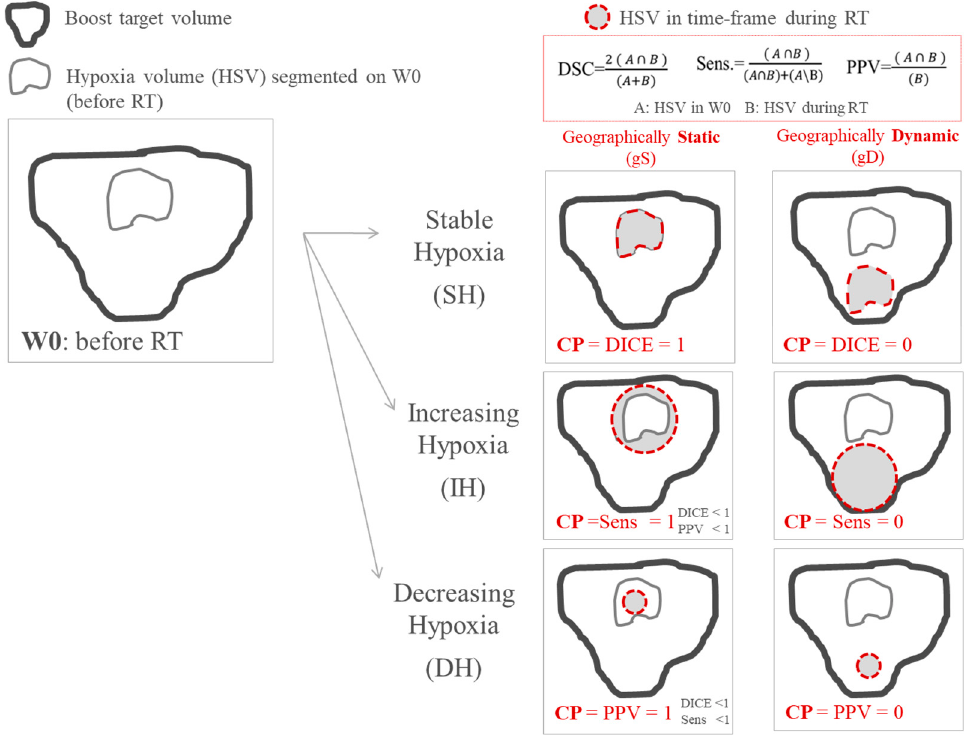
Figure 1. Scheme of the classification employed for classifying variations in size and location of tumor hypoxia during treatment. The classification parameter (CP) takes into account variations in size and location